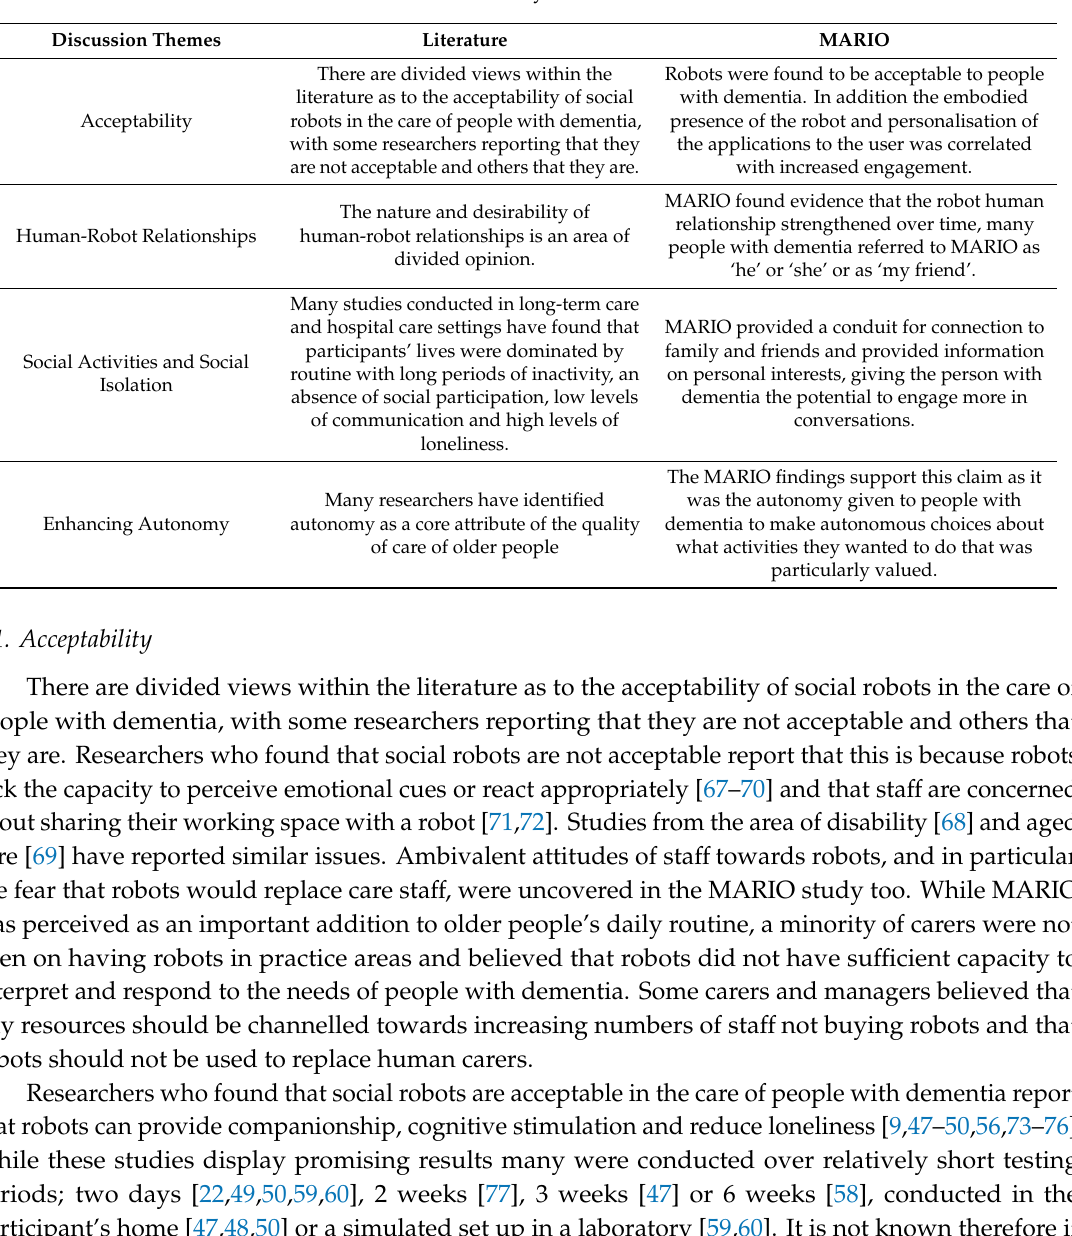
Table 3. Summary of